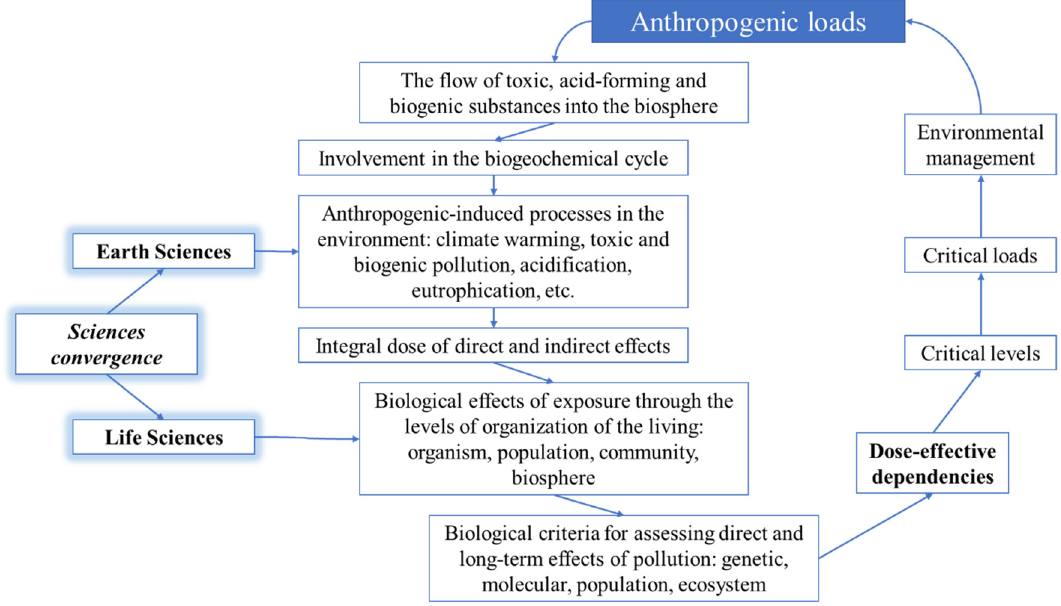
Figure 4. Flowchart of the estimation of critical loads and management of anthropogenic impacts.